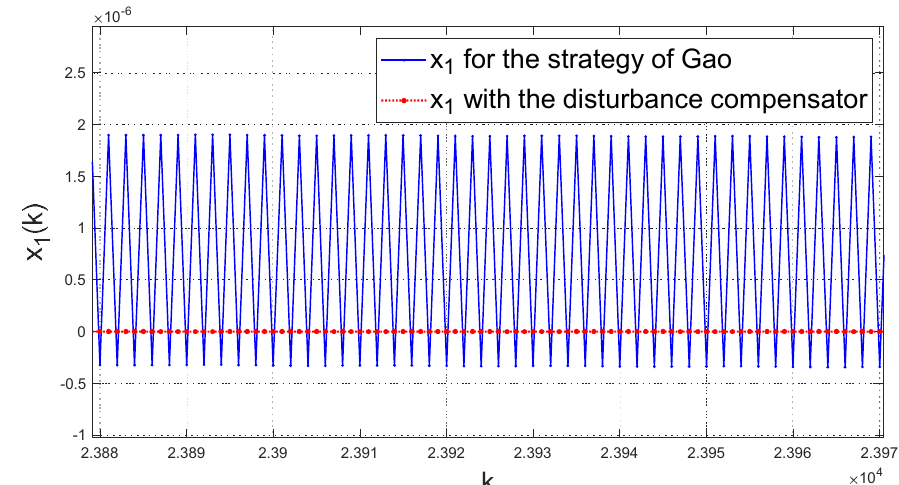
Figure 6. x 1 ( k ) for both control strategies.